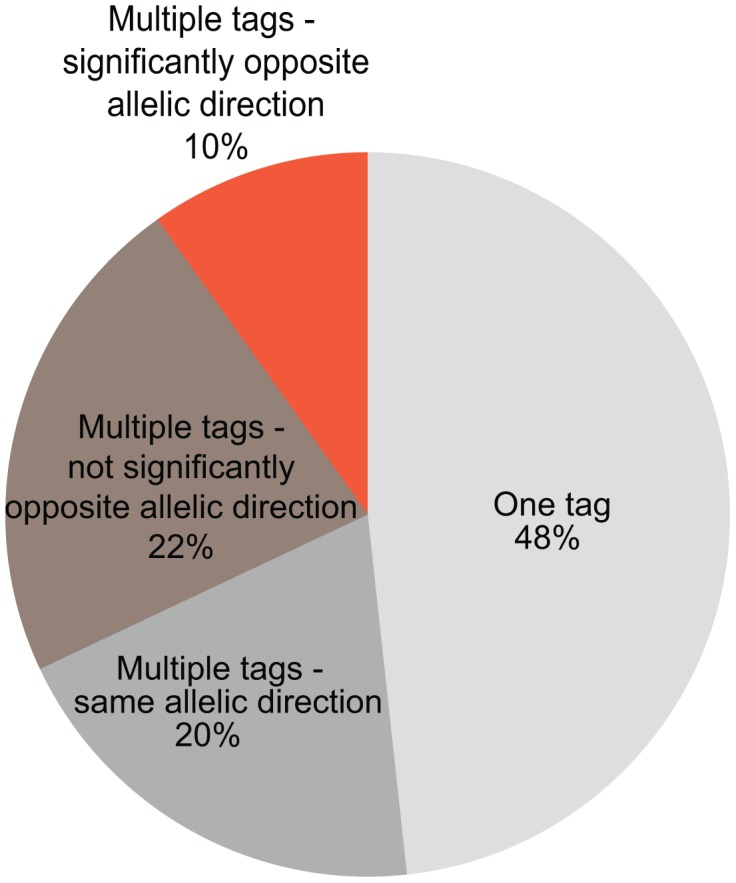
The number of cis-regulated tags per gene.The percentages of cis-regulated tags mapping into the same gene are indicated (781 genes overall). For nearly half of the genes (48%) only one tag shows an eQTL effect. If multiple tags map within the same gene, only one eQTL tag should pass the FDR<0.05 significance threshold while the other tag could be less significant. For these eQTLs the allelic direction is shown: same allelic direction (multiple tags within the same gene are cis-regulated by a SNP in the same direction), significantly opposite allelic direction (multiple tags within the same gene are cis-regulated by a SNP but with opposite directions and the difference between the correlation coefficients is significant), or opposite allelic direction but not significant (if the difference between correlation coefficients is not significant).